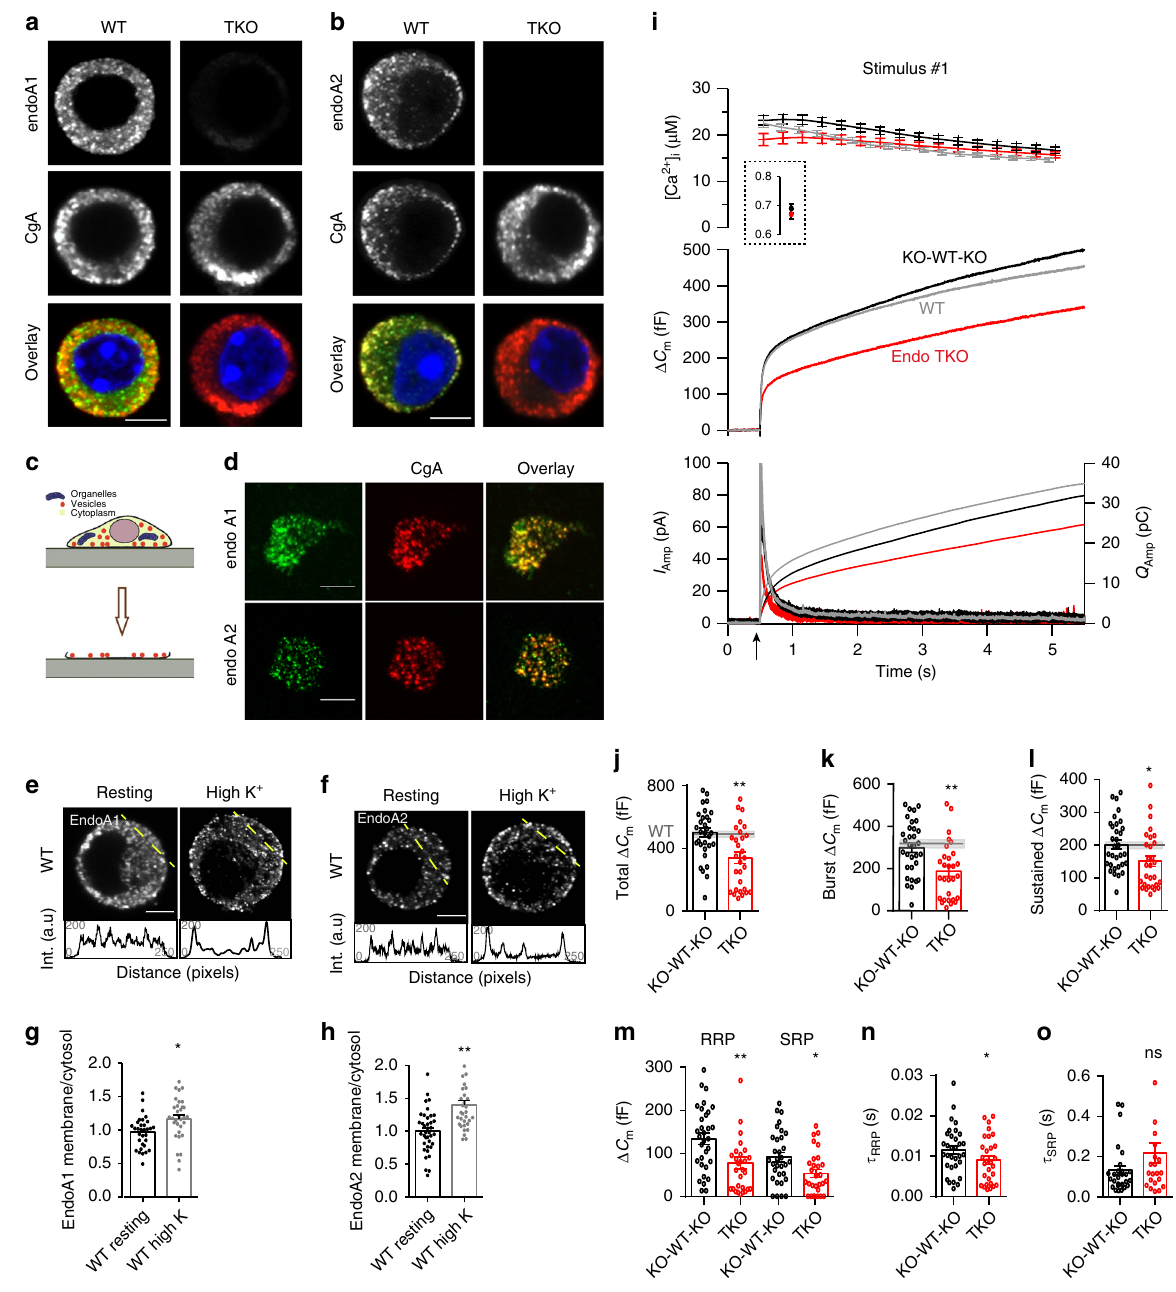
Fig. 1 Endophilins are enriched at neurosecretory vesicles and required for ef fi cient chromaf fi n cell exocytosis. a , b Representative confocal images of WT and endophilin TKO mouse chromaf fi n cells stained for endophilin-1 ( a ) or endophilin-2 ( b ), and co-labeled with chromogranin-A (CgA), a LDCV marker. Scale bar 3 µ m. For colocalization quanti fi cation, see Suppl. Fig 1c, d. c Plasma membrane sheet generation from cultured cells. d Representative plasma membrane sheets from chromaf fi n cells stained for endophilin-1 (top) or endophilin-2 (bottom) along with CgA. Scale bar 2 µ m.